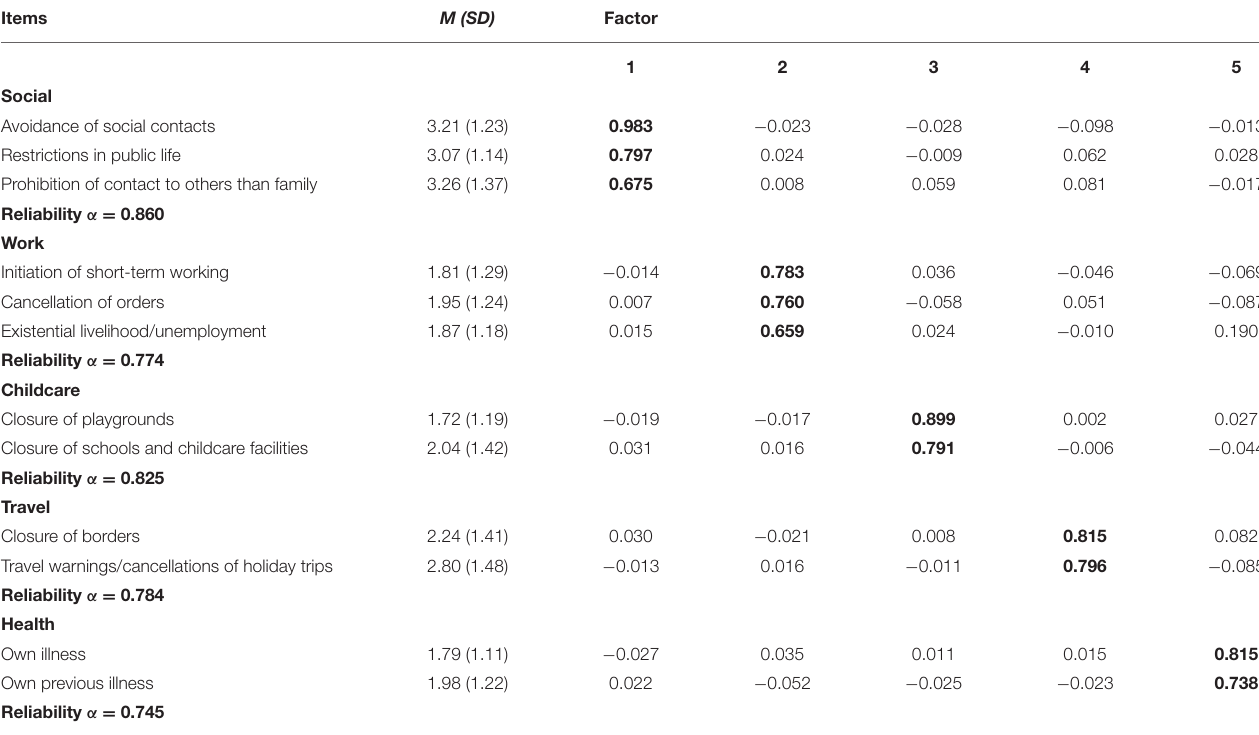
TABLE 2 | Item factor loadings, means, standard deviations, and Cronbach’s α of the subscales of the questionnaire assessing perceived strain due to COVID-19-related restrictions.